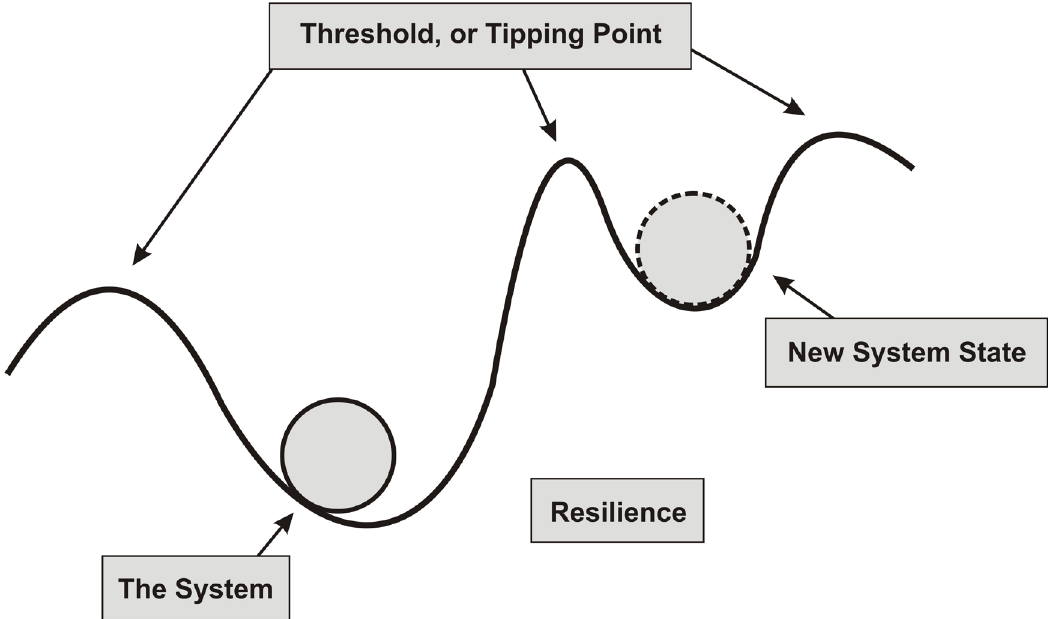
Figure 1. Equilibrium and non-equilibrium curves. The sphere represents the geosystem, and the valley indicates the state of the geosystem over time. The sphere’s position and the basin’s shape are constantly changing due to external conditions. Theoretically, the sphere tends to slide down the valley towards the equilibrium regime, and if the sphere moves beyond the edge of the valley, called the threshold, it will change the geosystem